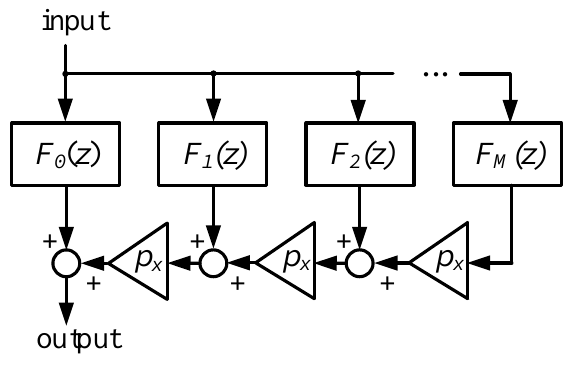
Figure 3. Scheme of a fractional delay approximation using Farrow